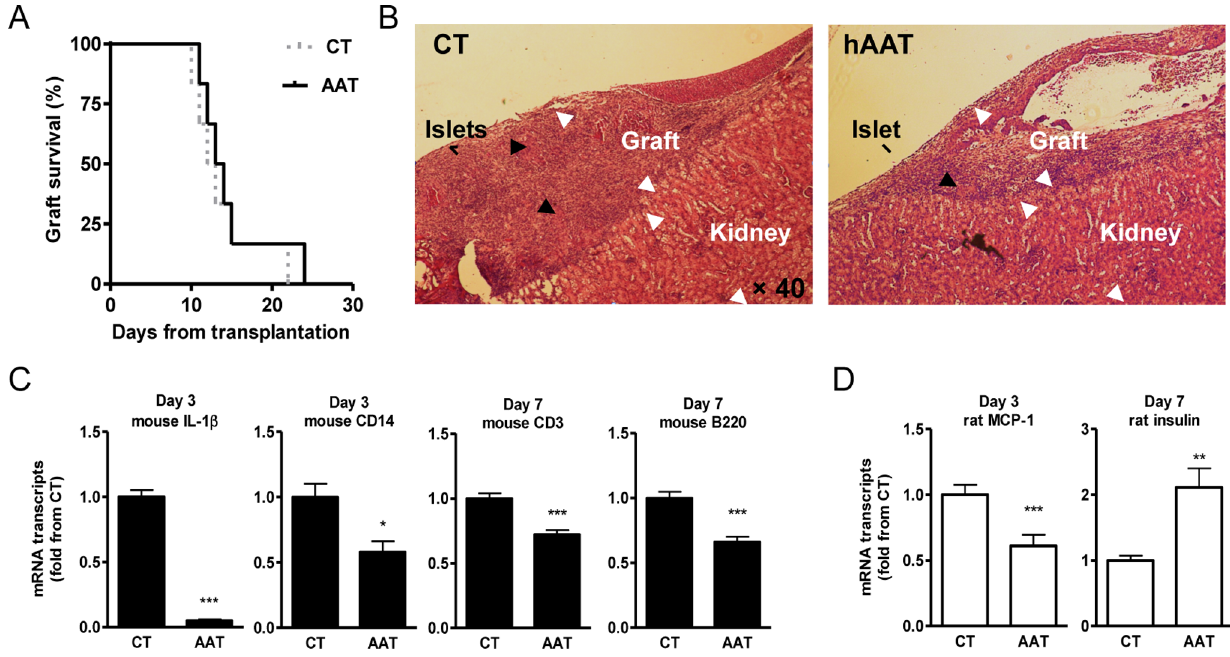
Figure 1. Human AAT monotherapy during pancreatic islet xenotransplantation. Rat pancreatic islets were grafted into the renal subcapsular space of hyperglycemic mice. Recipients were treated with saline (CT) or human AAT throughout the experiment. ( A ) Islet graft survival curve ( n =6/group). ( B ) Graft histology. Representative day-seven explanted grafts from CT and hATT-monotreated mice ( n =3/group). Black arrows , remains of rat pancreatic islets. ( C ) Mouse gene expression at graft site. Grafts were explanted at indicated times after transplantation. Mean 6 SEM from n =3 grafts/group; *p , 0.05, **p , 0.01, ***p , 0.001. ( D ) Rat gene expression at graft site. Grafts were explanted at indicated times after transplantation. Mean 6 SEM from n =3 grafts/group; **p , 0.01.